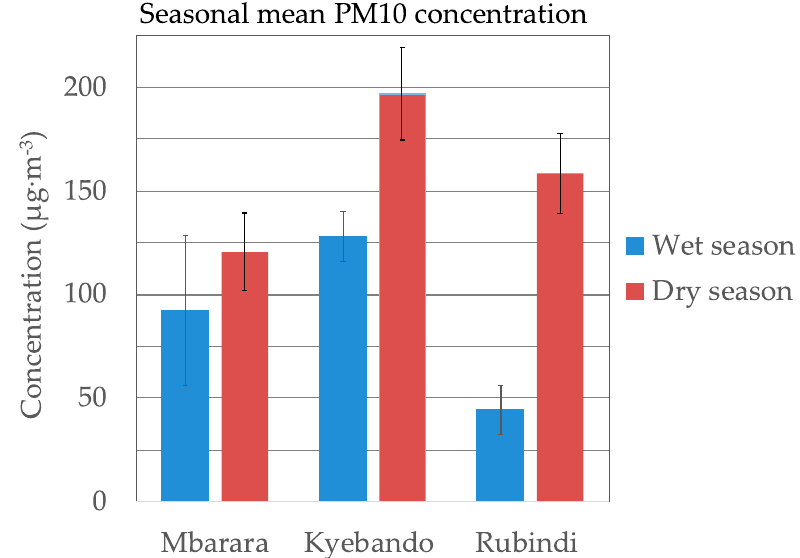
Figure 2. Comparison of mean PM 10 during dry and wet seasons. Error bars represent one standard deviation of the mean.